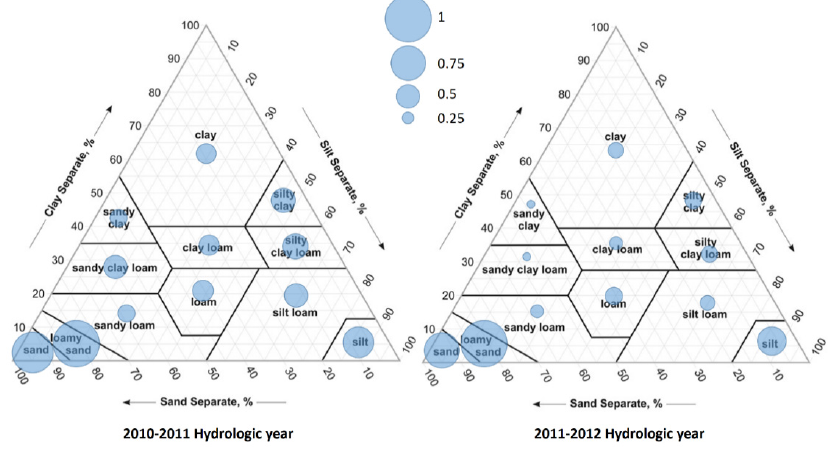
Figure 6. Temporal ice mass, 2010–2011 and 2011–2012 hydrologic years. Results were normalized ranging from 0 to 1; each circle represents the scaled result. A bigger circle indicates the highest value in the metric.